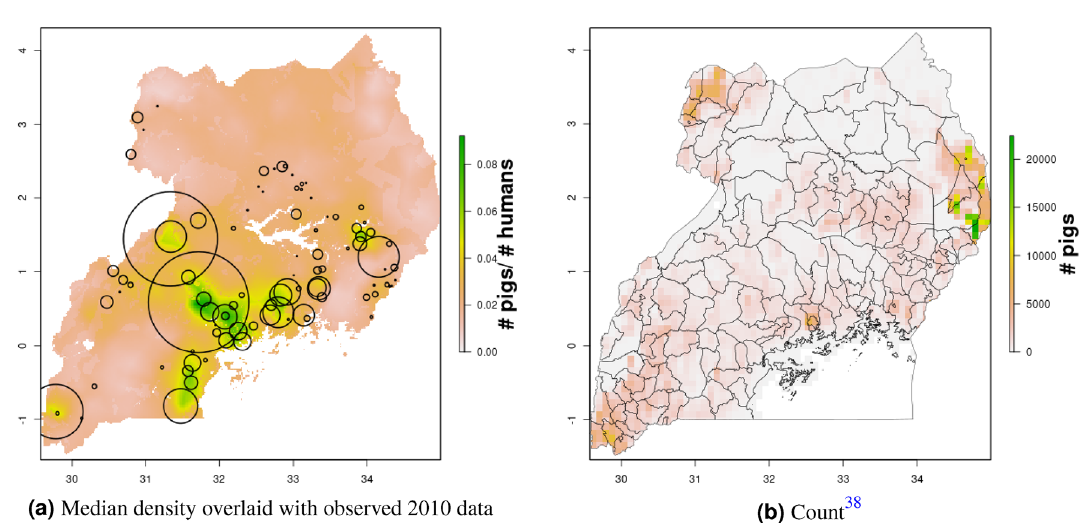
Figure 12. Median pig density (L) compared with estimated pig counts produced by GLW-3 (R) for Uganda, both 2010. Observed density data for 2010 are presented on the left, indicated by circle size; this figure does not represent the contribution of data from other years to the model for 2010 via the temporal random effect, nor the contribution from predictors 16 .